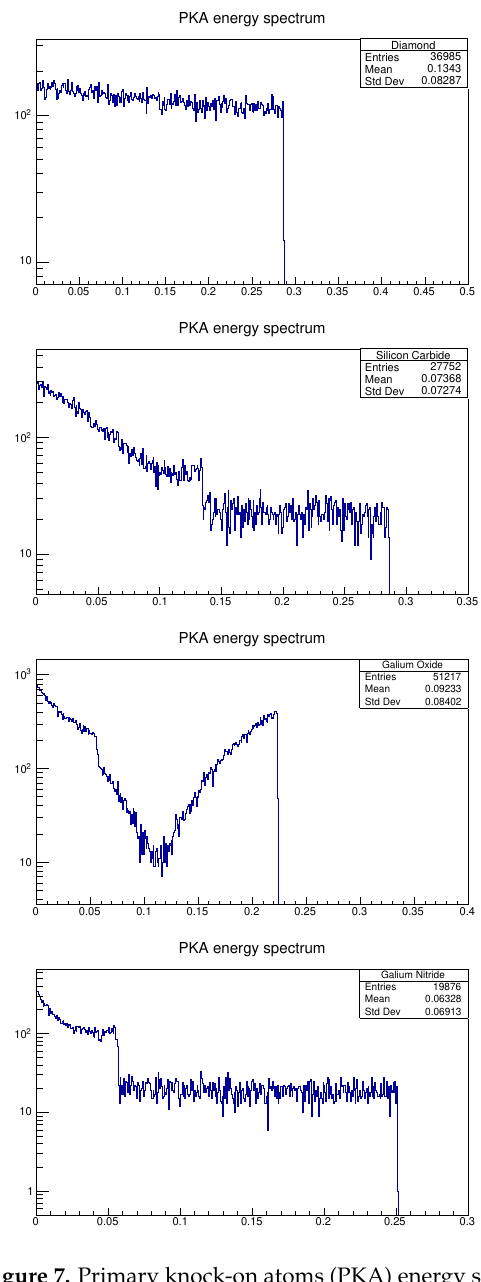
Figure 7. Primary knock-on atoms (PKA) energy spectra for diamond, SiC, Ga 2 O 3 and GaN. These energy spectra were created by ROOT. The X-axis shows the energy of PKA in MeV. The Y-axis shows the count number of PKA with a certain energy. The figure keys show: Entries, the total number of PKA; Mean, the average PKA energy in MeV; and Std Dev, the standard deviation of PKA energy